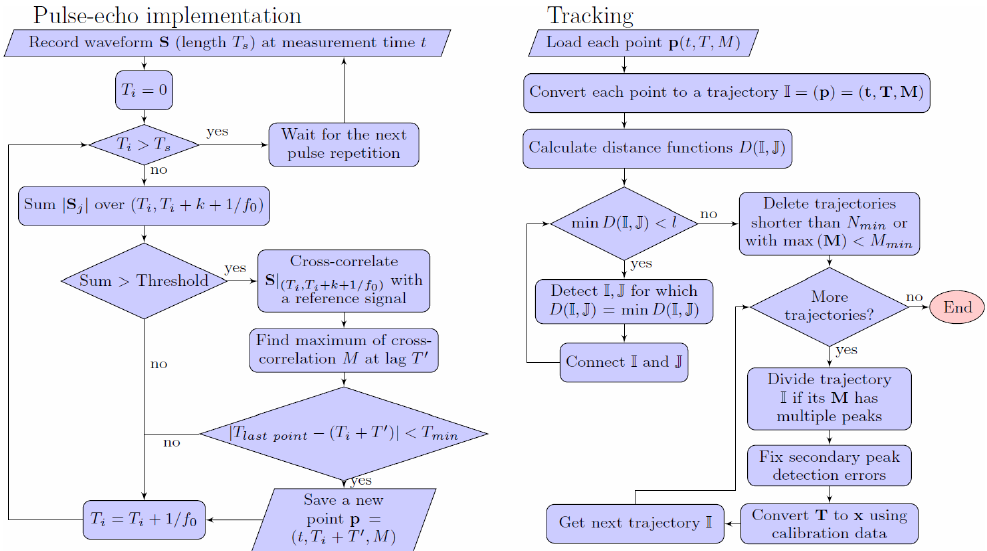
Figure 1. The flow chart of the